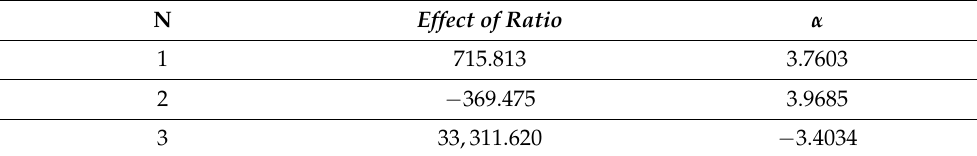
Table 6. Effect of ratio.